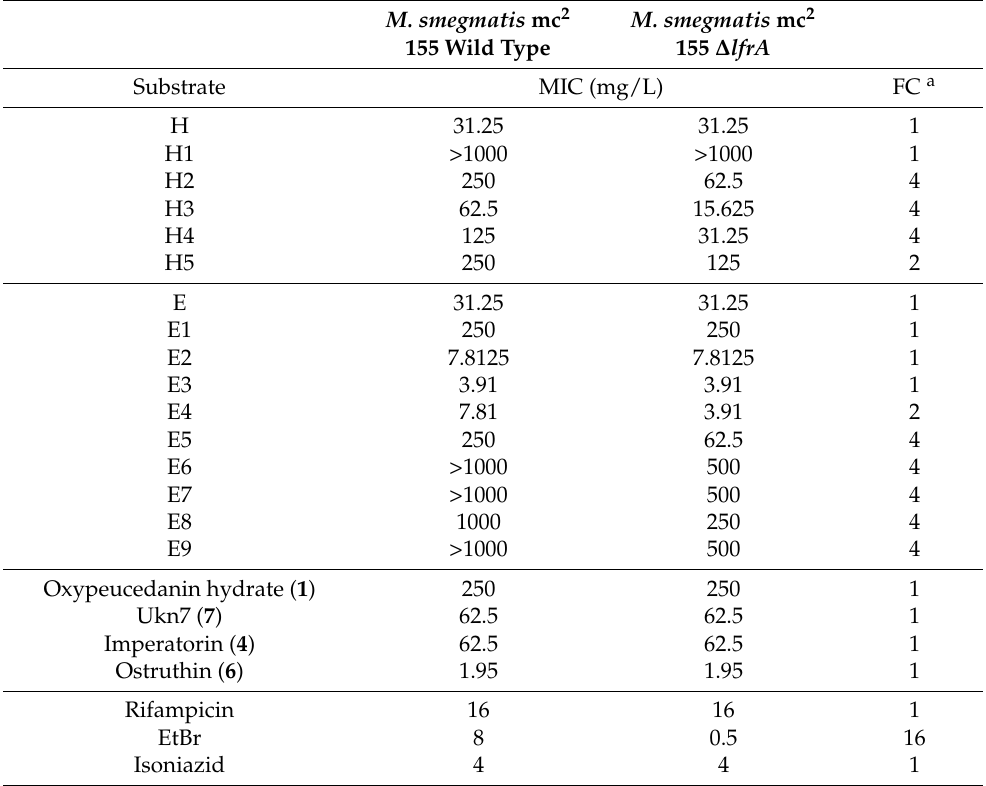
Table 2. Antimicrobial activity of P. ostruthium crude hexane (H) and ethanol extract ( E ) and their fractions (H1–H5 and E1–E9), pure compounds oxypeucedanin hydrate ( 1 ), Ukn7 ( 7 ), imperatorin ( 4 ), and ostruthin ( 6 ), isolated from the extracts, and antimicrobials rifampicin, isoniazid, and ethidium bromide (EtBr), against M. smegmatis mc 2 155 wild type and the efflux pump mutant strain ∆ lfrA , presented as the minimal inhibitory concentration (MIC) in mg/L with the corresponding fold change (FC) in antimicrobial susceptibility of the ∆ lfrA mutant compared to the wild type.